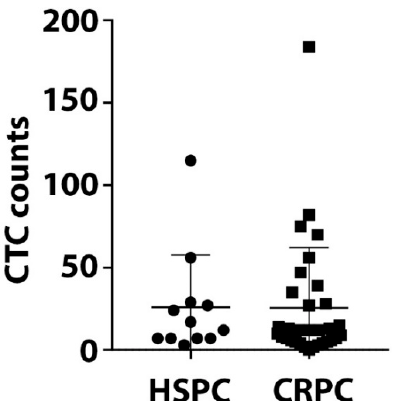
Figure 2. Circulating tumor cells (CTC) counts. CTCs were isolated using the IsoFlux CTC platform and enumerated. The range of CTC counts/9 mL blood for 12 HSPC and 32 CRPC patients is depicted. There is no significant difference of CTC numbers between HSPC and CRPC patients ( p value = 0.59).